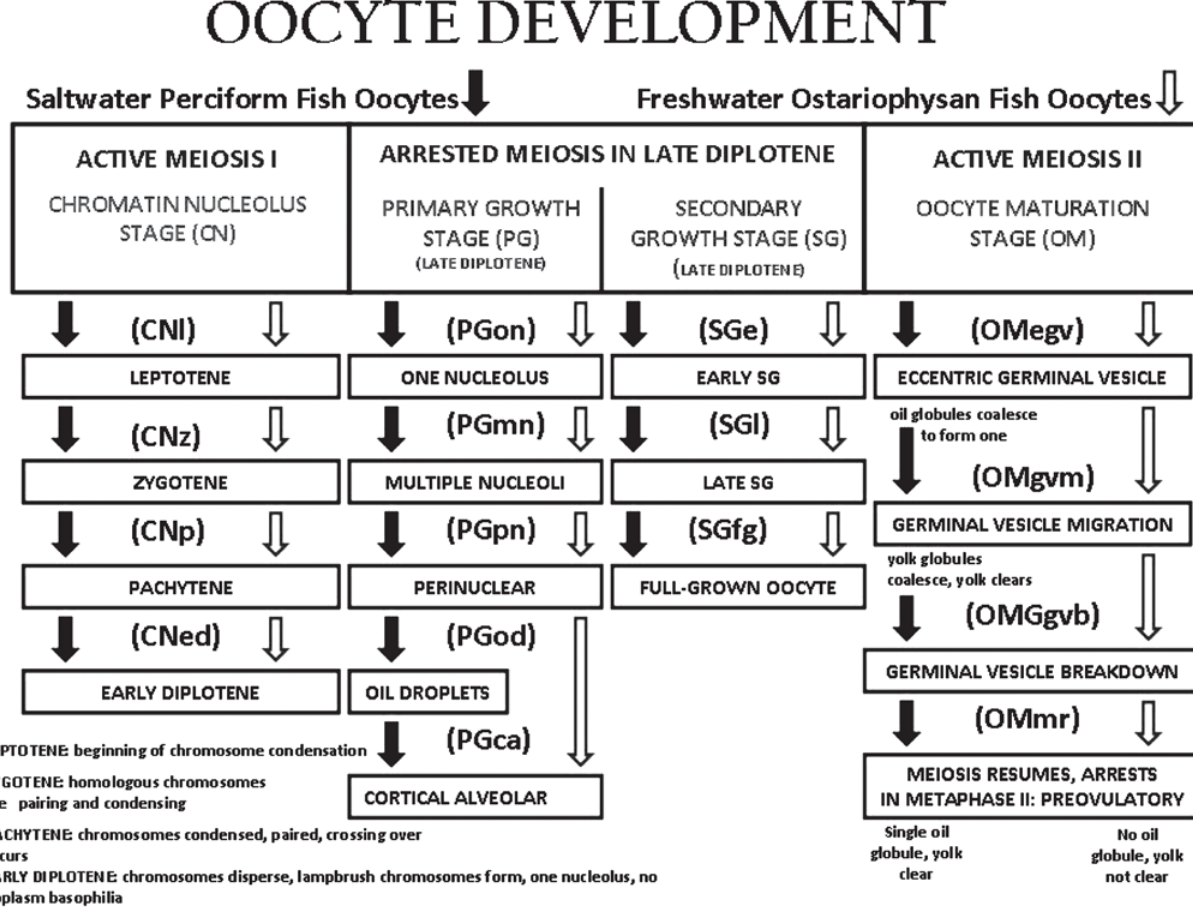
Fig. 7. Schema comparing oocyte development in a saltwater perciform, Sciaenops ocellatus and in a freshwater gymnotiform, Gymnotus sylvius